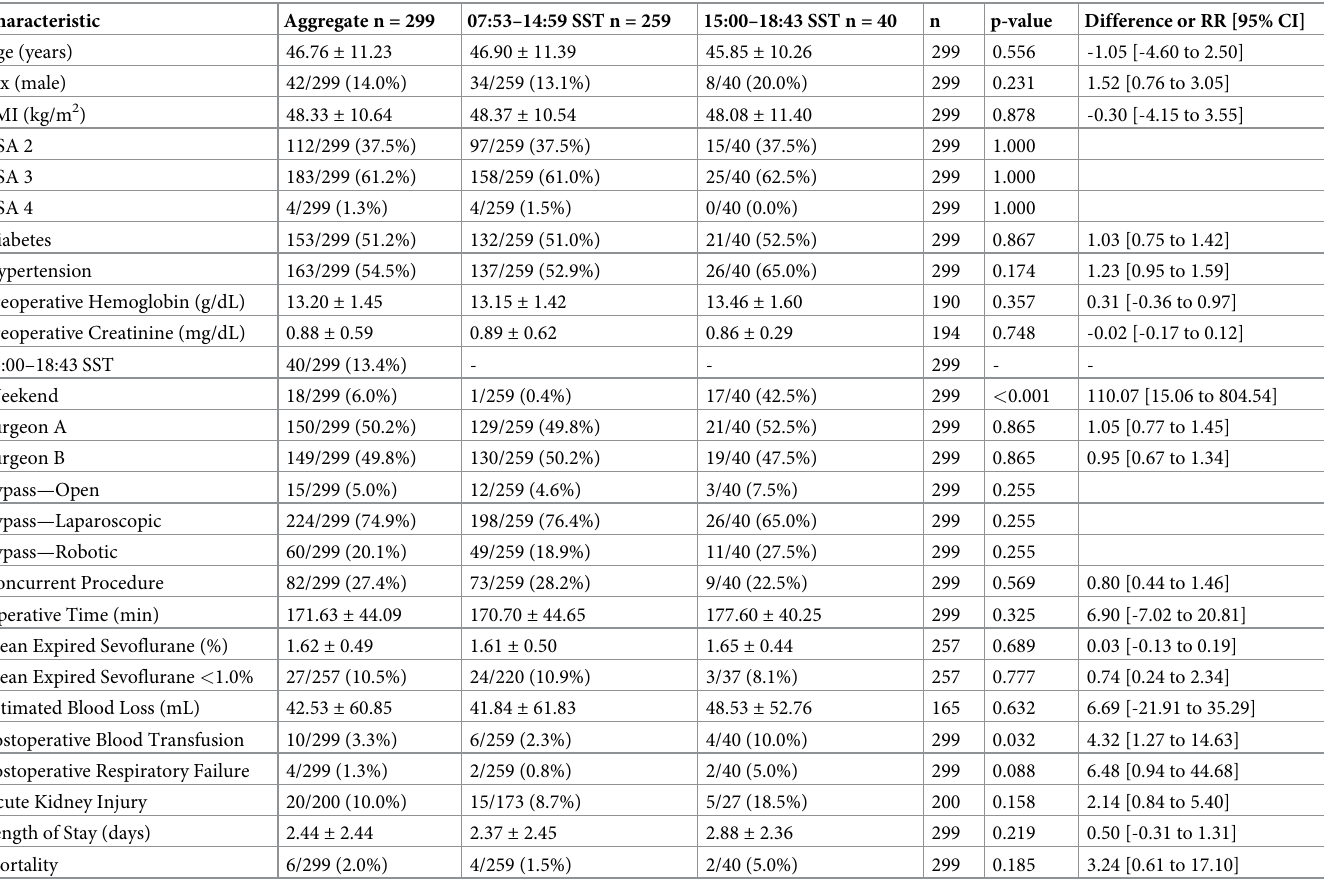
Table 1. Demographic data and univariate comparisons between SST cohorts.